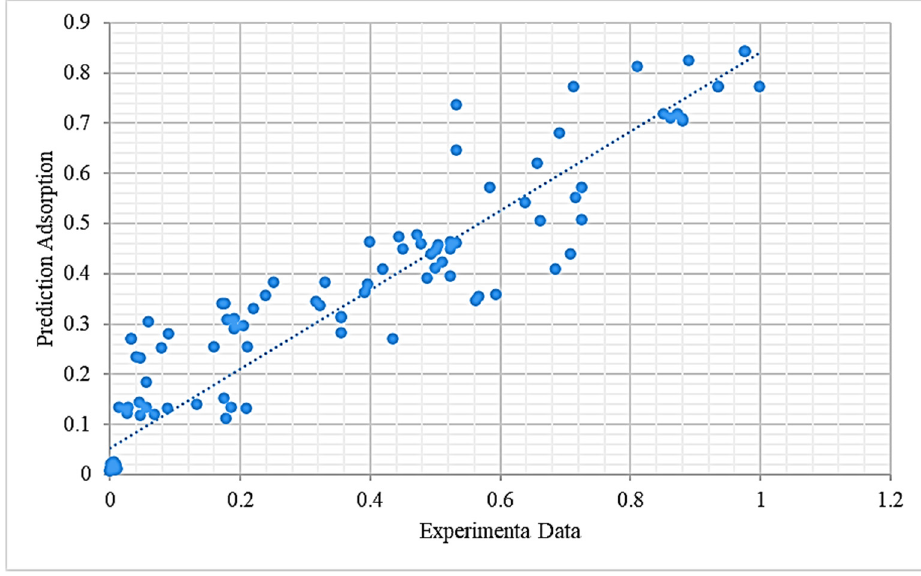
Figure 3. Predicted adsorption efficiency versus experimental data using random forest (RF) model.